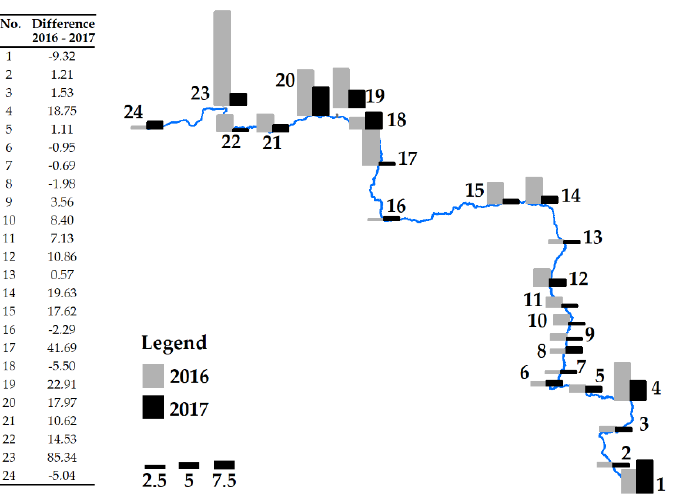
Figure 8. Comparison of Metal Pollution Index (MPI) in bottom sediments of Warta River in 2016 and 2017.